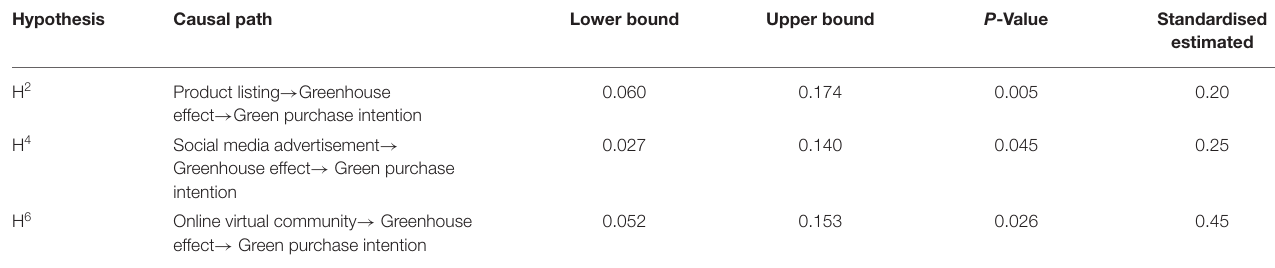
TABLE 7 | Results of the structural model: direct effects (H 2 , H 4 , and H 6 ). Hypothesis